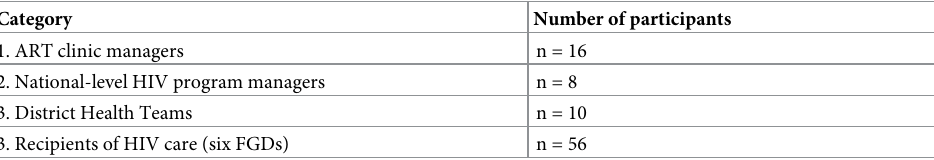
Table 2. Category of participants in qualitative arm of the study.